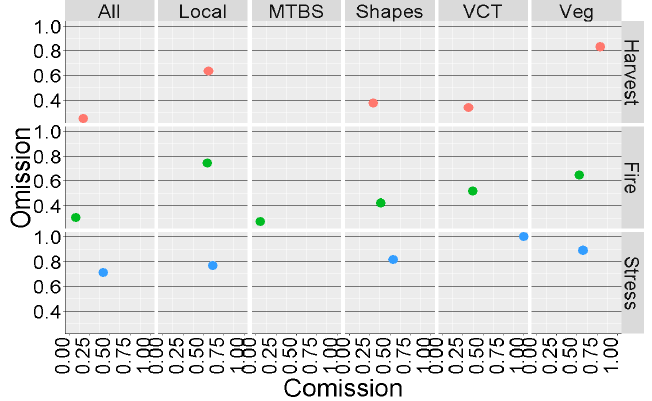
Figure 4. Models were built with “All” and separately with subsets or suites of predictor variables, to assess their individual contributions to omission and commission accuracy metrics for the major event type classes of removal, fire and stress. Subsets of predictor from “Local” geographic variables, MTBS